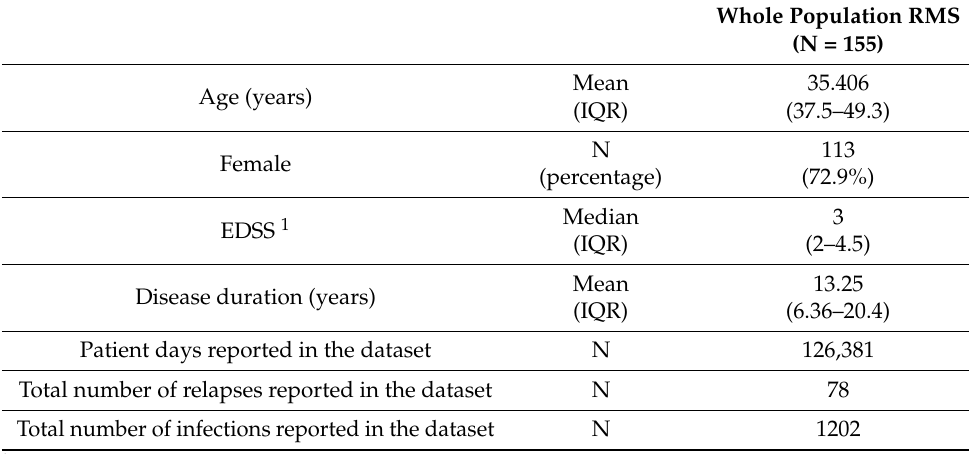
Table 1. Demographic characteristics of the whole